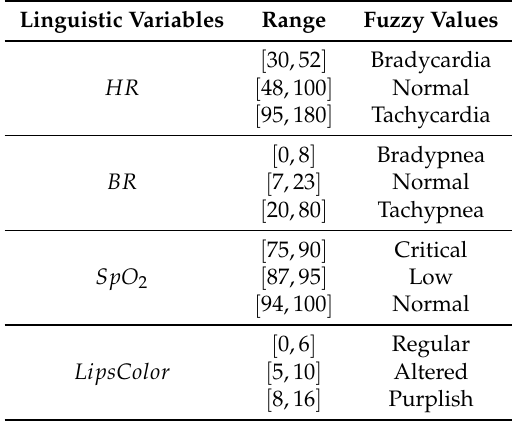
Table 1. Values for all input linguistic